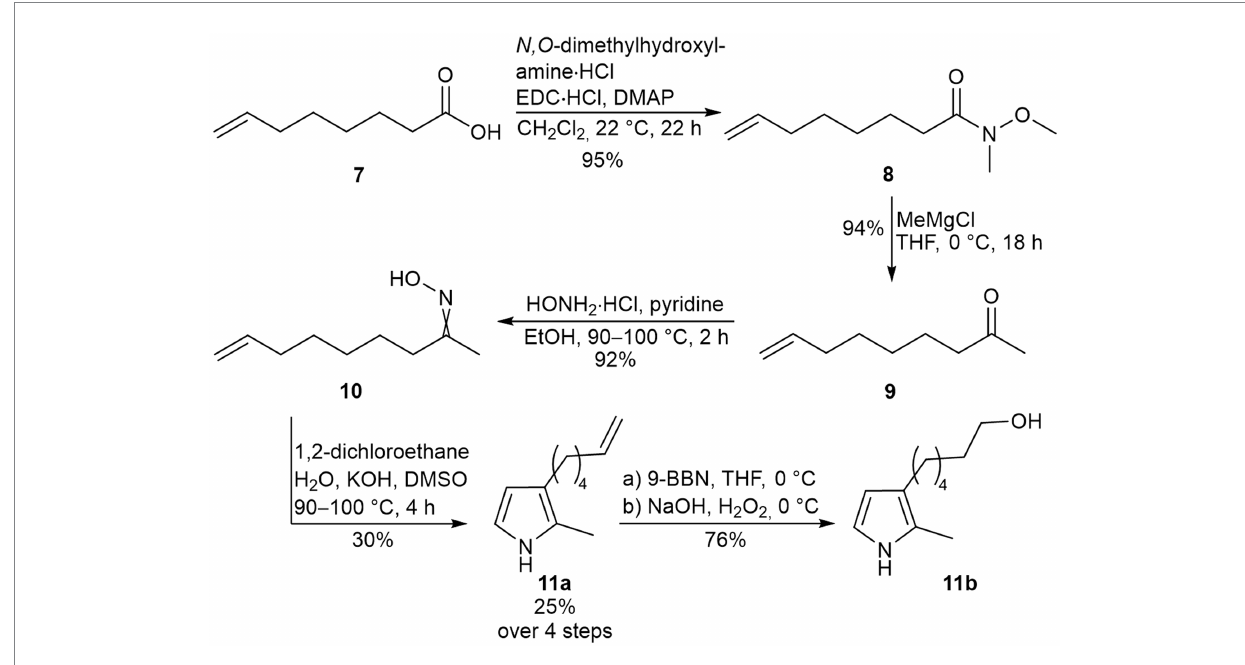
FIGURE 3 Synthesis route toward the 2,3-disubstituted pyrrole precursors 11a and 11b